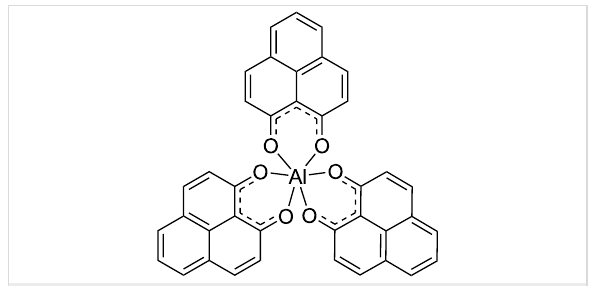
Figure 1: Tris(1-oxo-1 H -phenalen-9-olate)aluminum(III) (Al(Op) 3 ) structure. H atoms are omitted for